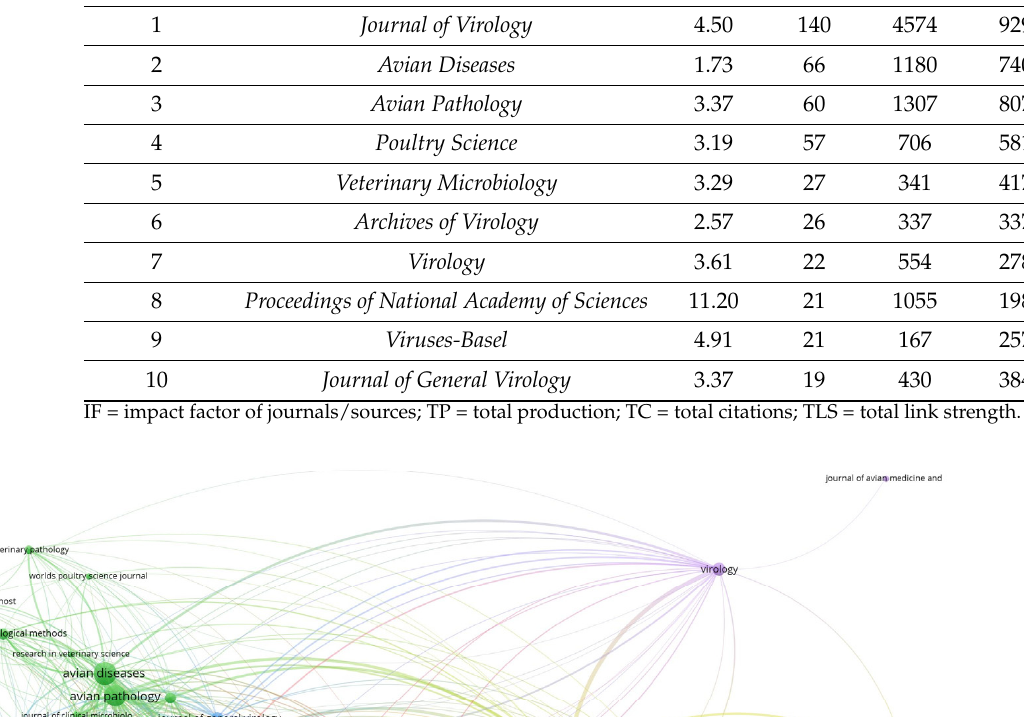
Table 2. The most influential journals/sources in the avian leukosis virus research. Ranks